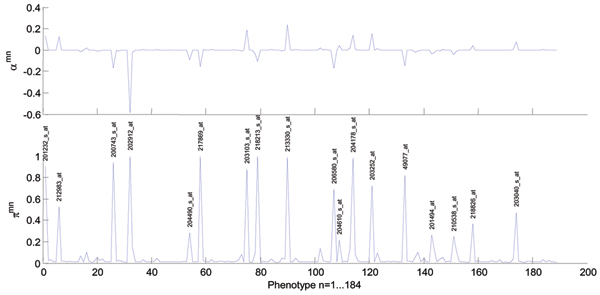
Potential master regulatory region around rs916482 SNP. Bottom plot is the cross-section of column 84 of Figure 1, describing the association between all phenotypes in chromosome 11 and SNP m = rs916482. The top plot shows the sign of dependence on the genotype. This SNP has a large number of associated genotypes, providing a strong indication of a master regulatory region.